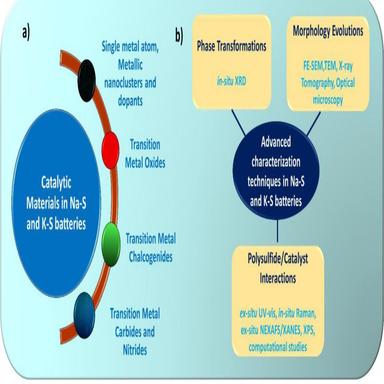
Schematic of a) various catalytic materials and b) advanced characterization techniques utilized in NaeS and KeS batteries.